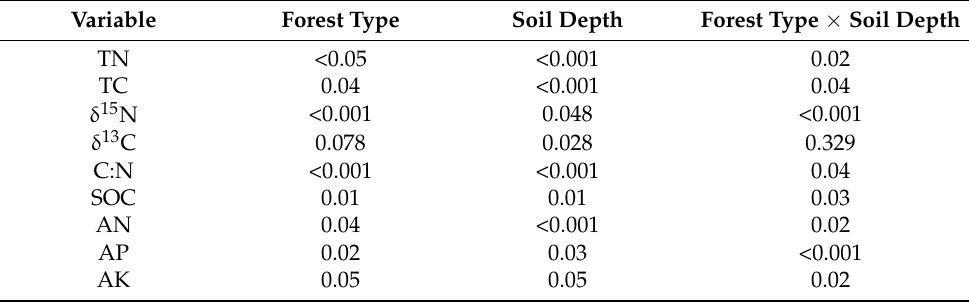
Table A1. Two-way ANOVA results ( p values) for the studied soil variables at p ≤